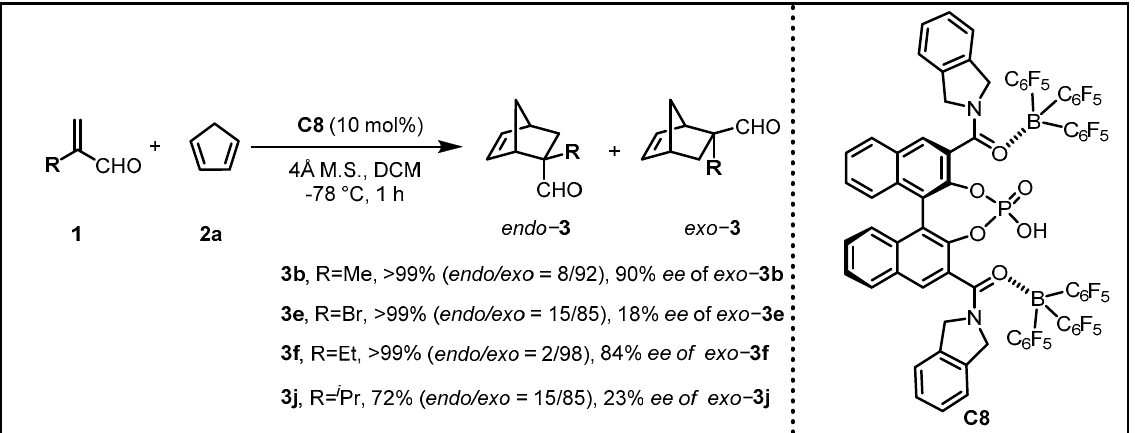
Figure 5. Substrate specificity with the use of LBA catalyst C8